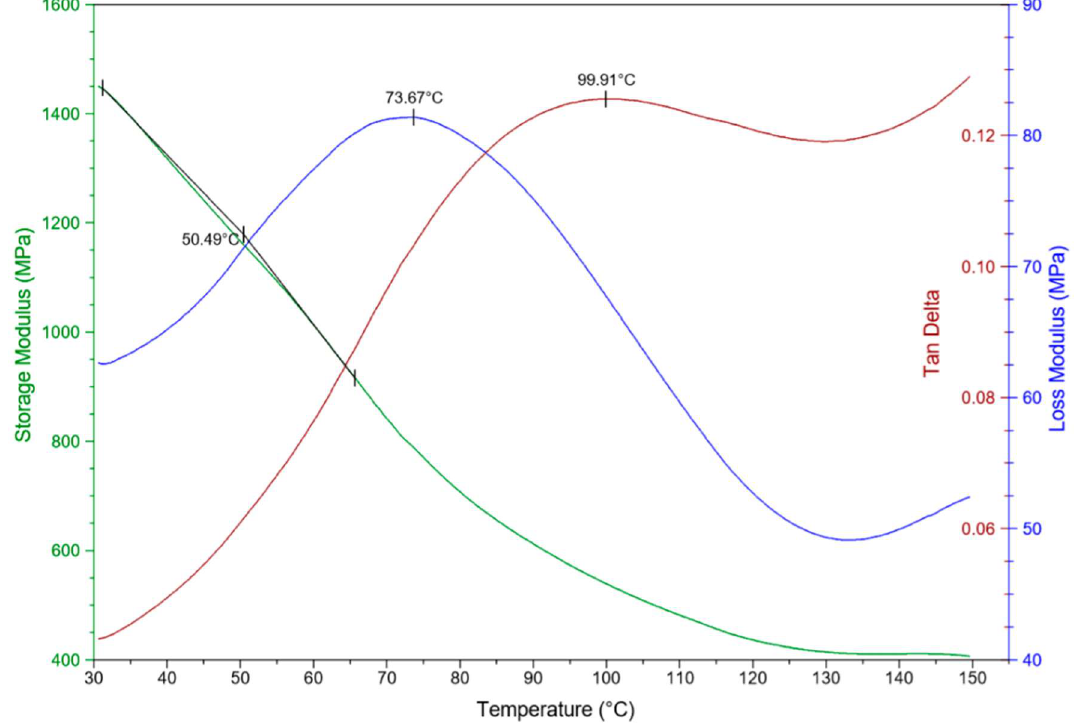
Figure 4. Typical DMA plot analysis presenting the impact on storage and loss modulus.